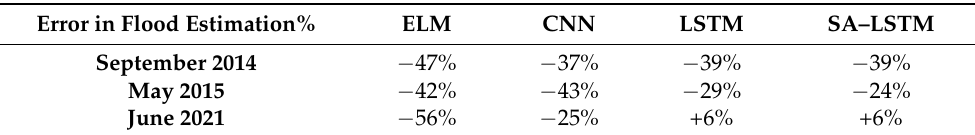
Table 5. Summary of estimation errors for each model for the three highest flowrates during the testing period.